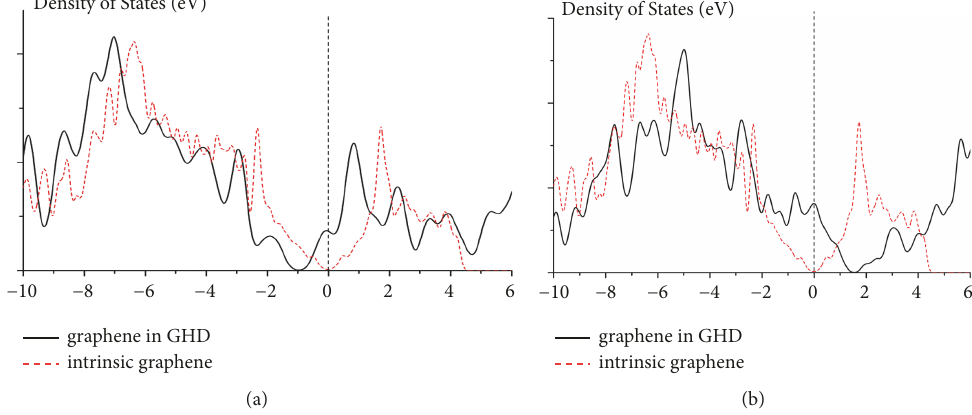
Figure 4: Calculated DOS plots for intrinsic graphene (red dashed) in addition to (a) a monolayer graphene adhered to an H-terminated diamond surface (black), or (b) a monolayer graphene adhered to an O by a black dashed